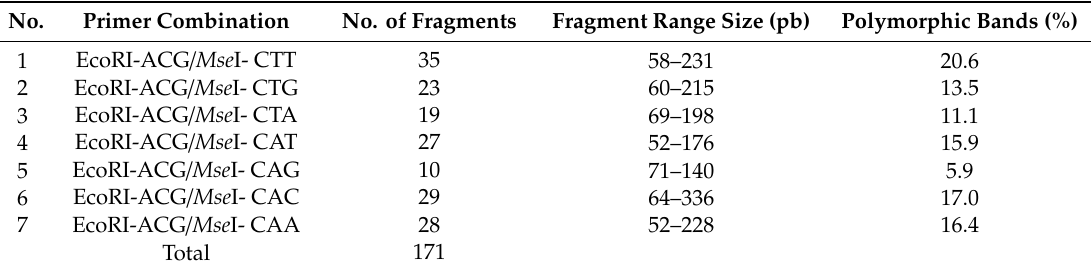
Table 2. Description of the primer